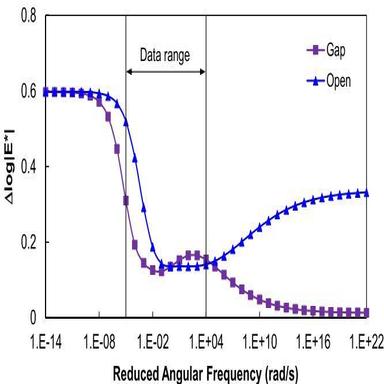
Distribution of the vertical shift factor required to converge the master curves.